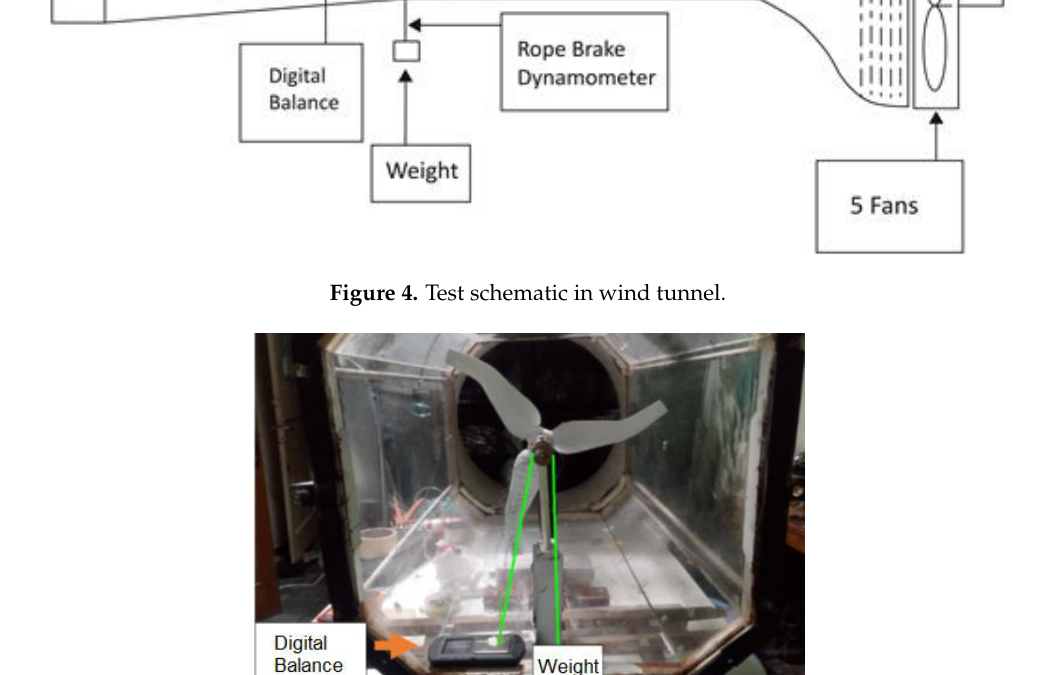
Figure 5. Measurement set-up in wind